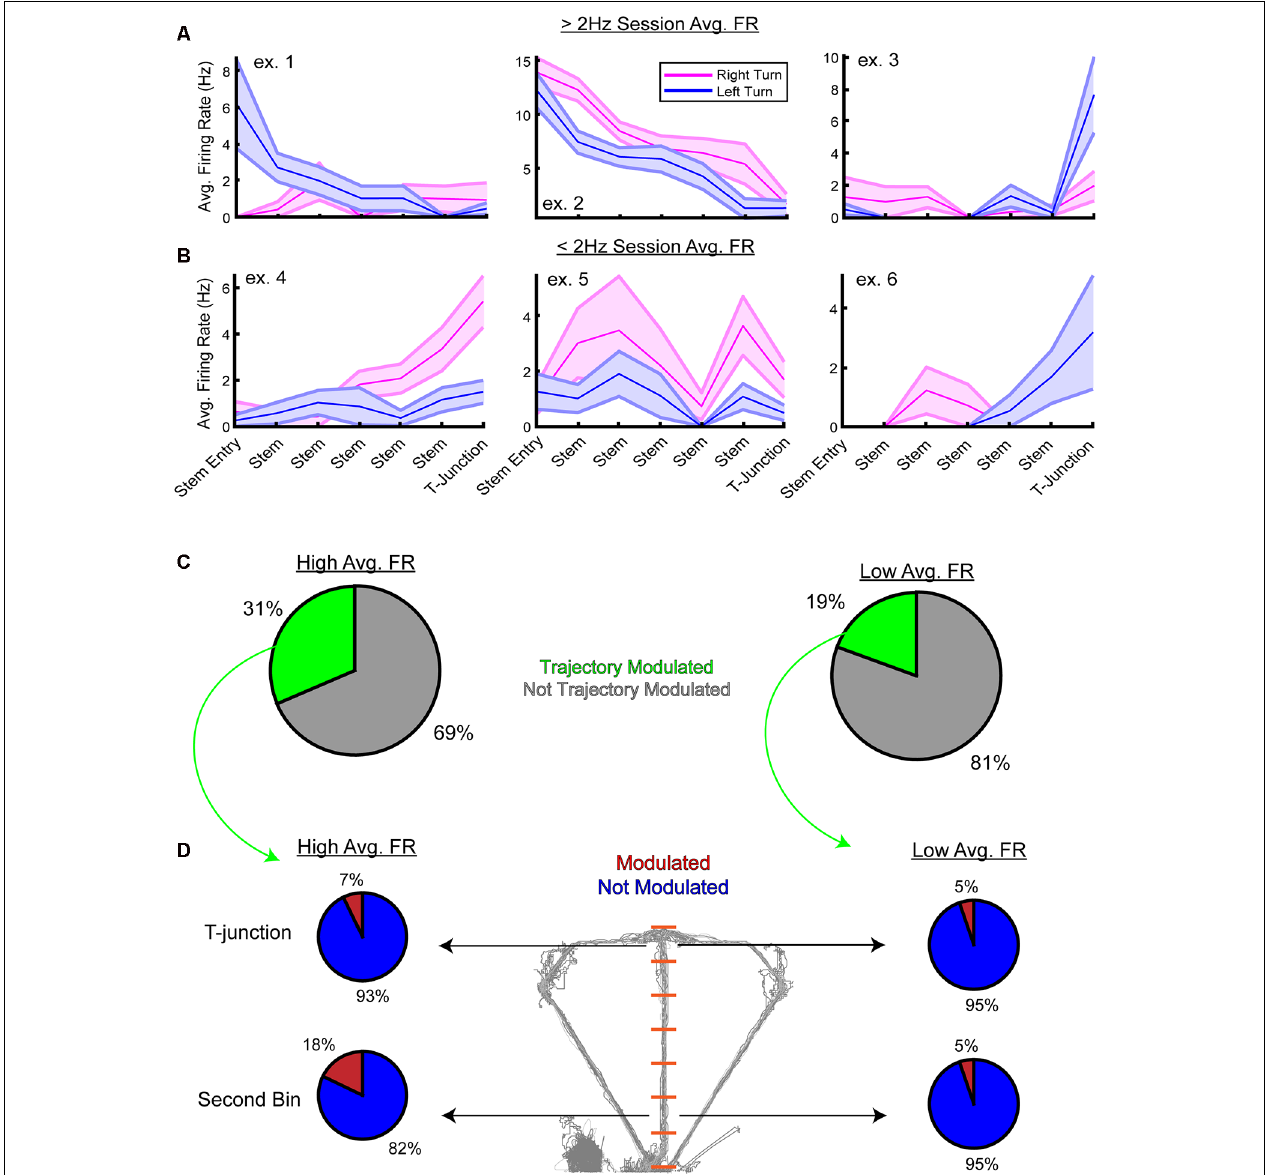
FIGURE 6 | Trajectory modulation is evident at the single-unit level from the high and low-rate populations. (A) Three example units from the high-rate population that were significantly modulated by trajectory on the stem of the DNMP task. Using a two-way analysis of variance, a unit was considered “significantly modulated” if there was a significant main effect of trajectory or a significant interaction between stem bin and trajectory on firing rates. Data are displayed as the trial-averaged mean ± SEM of firing rates. (B) Three example units from the low-rate population that were significantly modulated by trajectory. Note that while units exhibited a session average of < 2 Hz, their firing rates on the stem can be above 2 Hz. (C) Pie charts from the high-rate population (left panel) and low-rate population (right panel) demonstrating the proportion of units modulated by trajectory. Note the greater percentage of high-rate neurons that are trajectory-modulated. (D) Follow up paired t -tests were performed on firing rates from the T-junction and the second stem bin. Alpha level was corrected using Bonferroni’s method (alpha = 0.025) and only units that had a p-value less than the corrected alpha level were included. Notice in the high-rate population, 18% of units were significantly modulated during early stem running, and 7% were modulated at T-junction. This is in contrast to the low-rate population where only 5% of the trajectory-modulated units exhibited preferential firing towards one trajectory at the second stem bin and T-junction. Note that the second stem bin is the first bin where the rat is completely enclosed by stem